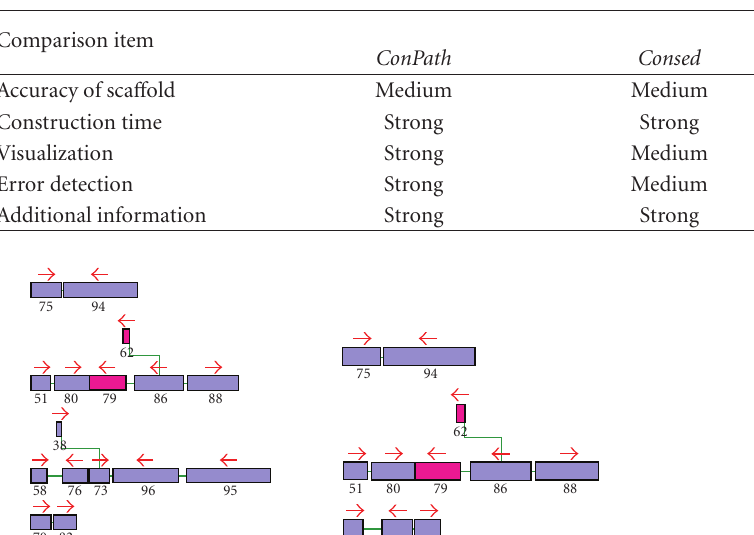
Table 4: Comparison of ConPath with other sca ff old tools.